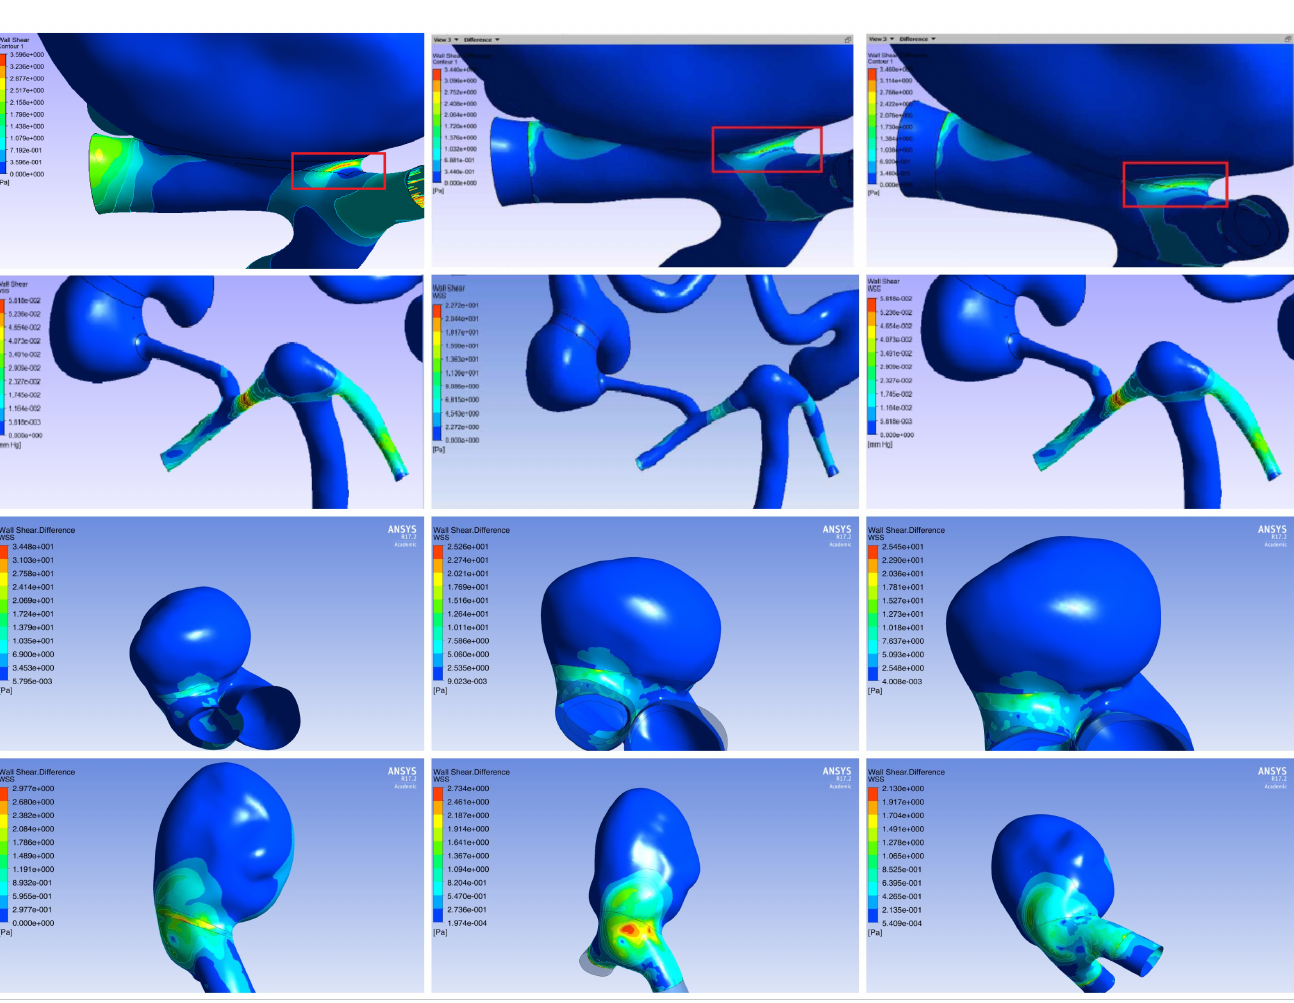
Figure A5. Distribution of ∆ WSS for all patients (number of row corresponds to an identifier of patient) in steady simulations: Column 1: Scenario A, Column 2: Scenario B, Column 3: Scenario